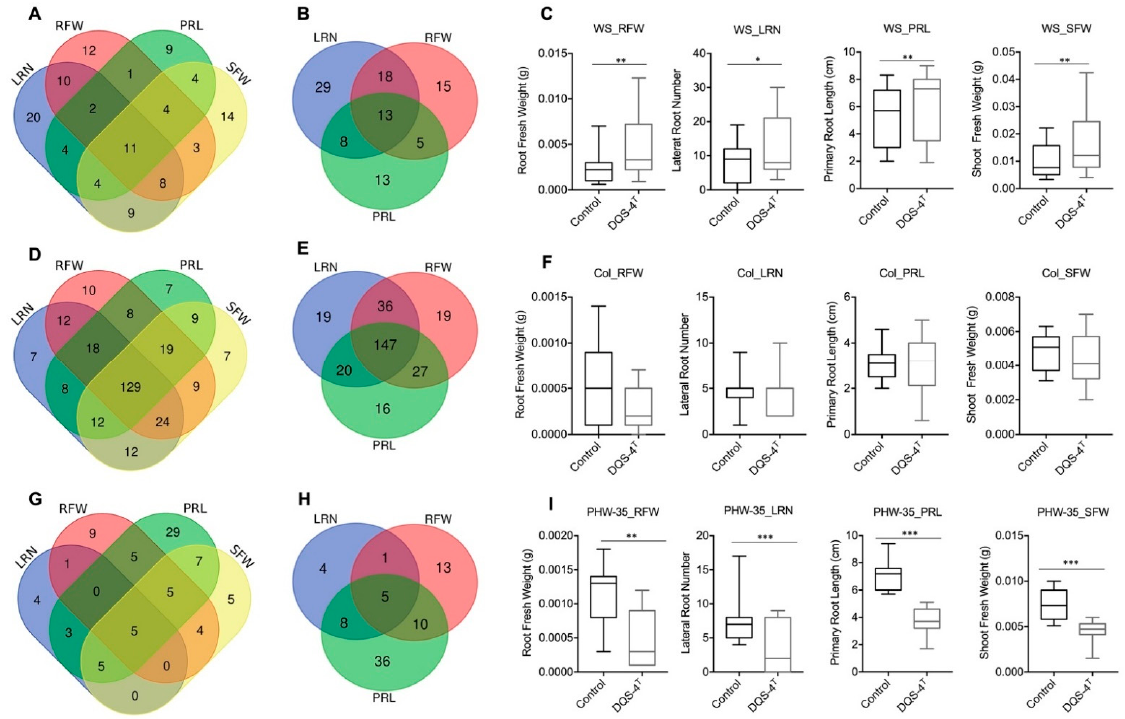
Figure 2. Growth responses of control and inoculated Arabidopsis accessions. Venn diagram showing the total number of common accessions across traits in each response category. ( A ) Responsive accessions to DQS-4T inoculation for root and shoot traits. ( B ) Responsive accessions in root growth parameters. ( C ) Significant response of Wassilewskija (WS) genotype upon inoculation with DQS-4T in all four traits. ( D ) Venn diagram of non-responsive accessions to DQS-4T inoculation for each root and shoot traits. ( E ) Significant non-responsive accessions in root growth parameters. ( F ) No significant response of Col-0 upon inoculation with DQS-4T in all four traits. ( G ) Accessions that responded negatively to DQS-4T inoculation in each trait analyzed. ( H ) Negative response accessions in root growth parameters. ( I ) Significant response of PHW-35 control upon inoculation with DQS-4T in all four traits analyzed. Bars are an average of three biological replicates (n = 15). Statistical analysis was carried out using one-way ANOVA with Tukey’s test p -value = 0.05 (* p ≤ 0.05; ** p ≤ 0.01; *** p ≤